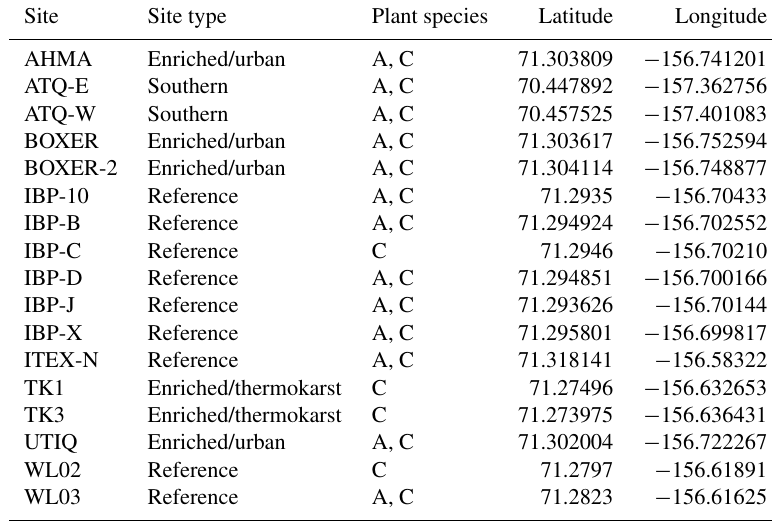
Table A1. Study sites and plant types. Plants species included C. aquatilis (C) and A. fulva